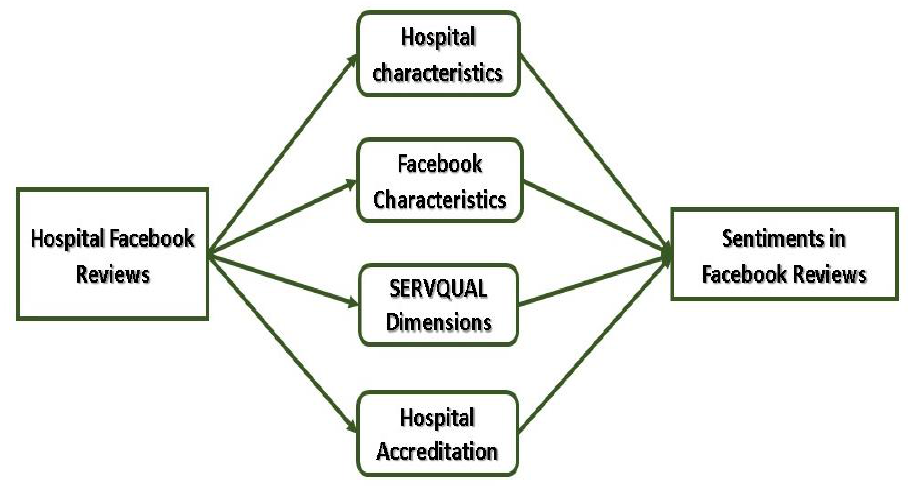
Figure 1. Conceptual framework for proposed work.